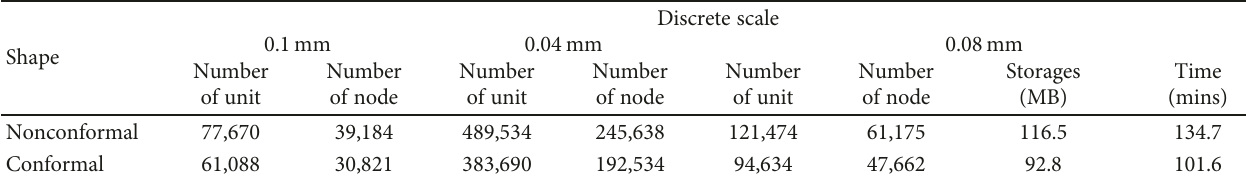
Table 1: Comparison of the number of unit and node in di ff erent calculated regions.